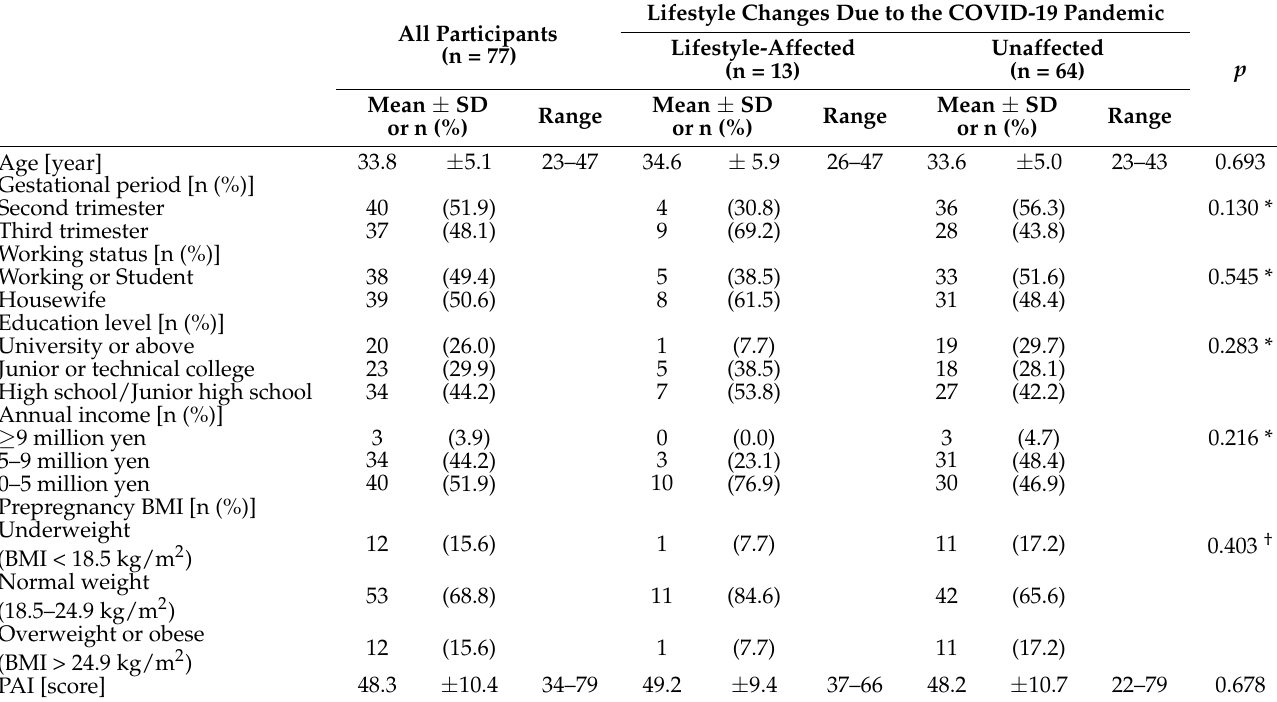
Table 2. The characteristics of multipara participants.